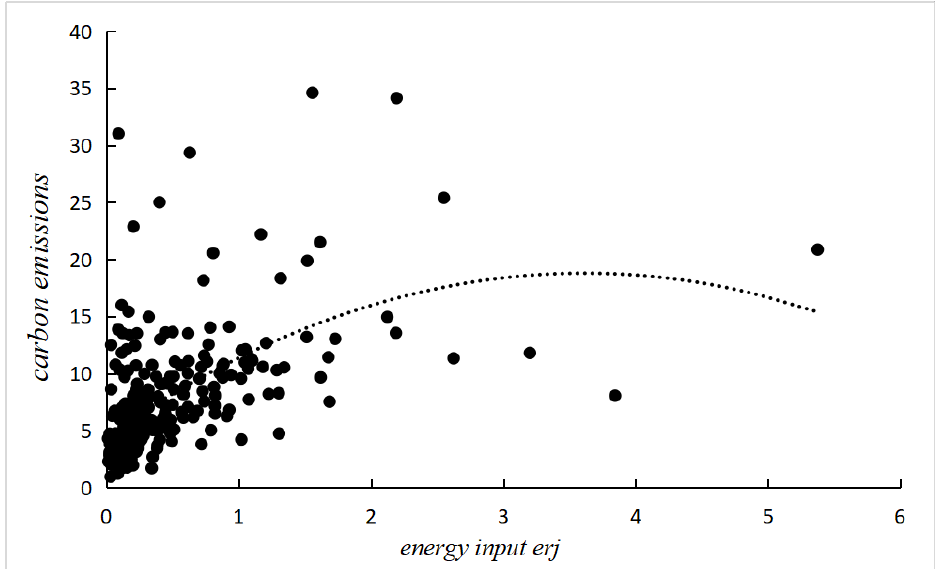
Figure 3. Impact of energy input on CO 2